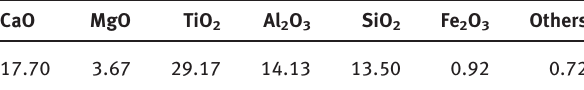
Table 1: Chemical compositions of the slag (wt%).